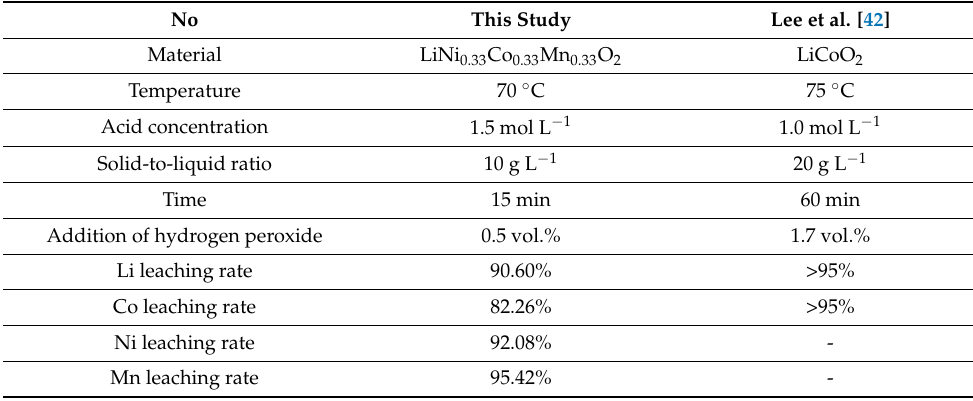
Table 5. Comparison of nitric acid leaching results.